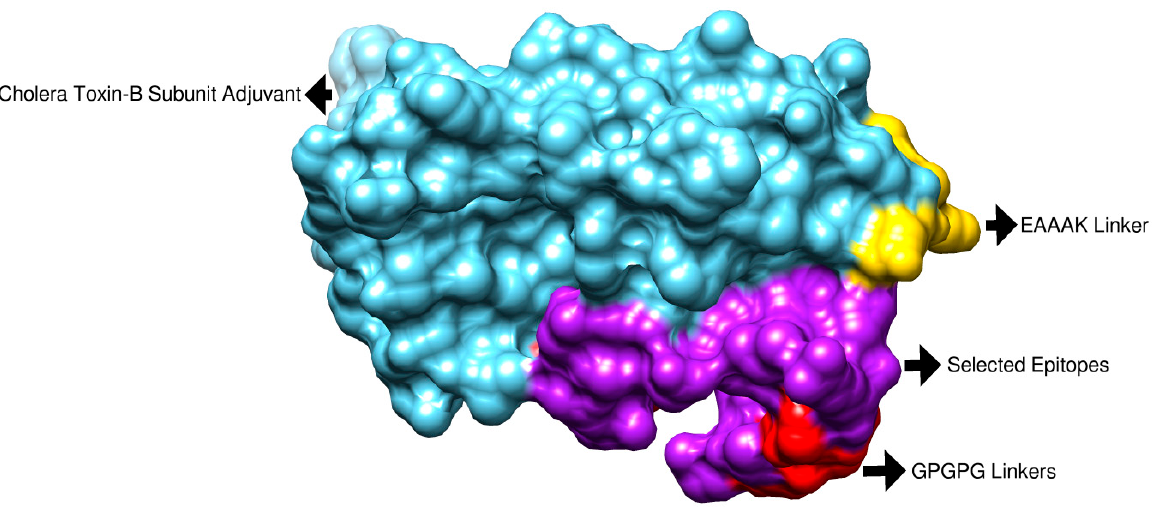
Figure 5. Three-dimensional (3D) structure of the designed vaccine construct. Each component of the vaccine is shown.